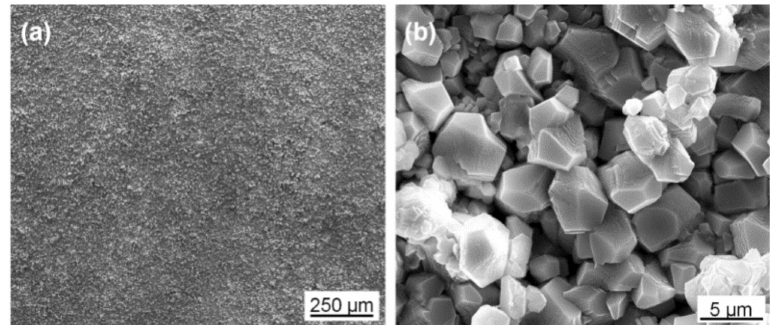
Figure 8. SEM micrographs of the samples HT2 ( a , b ) after static immersion in SBF solution at 37 ◦ C for 5